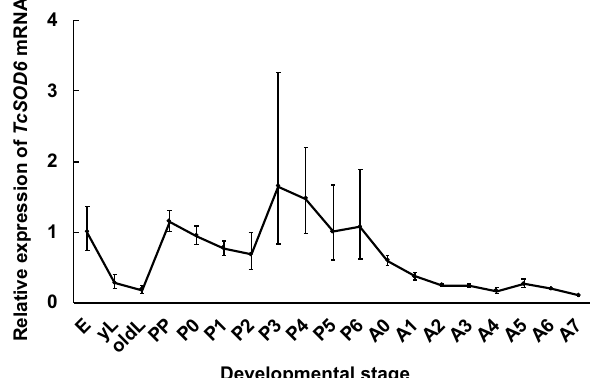
Figure 3. TcSOD6 mRNA expression during development. mRNA expression of TcSOD6 during development. E; embryo (n = 30), yL; young larva (n = 3), oldL; old larva (n = 3), PP; pharate pupa (n = 3), P0–P6; day 0–6 of the pupal stage (n = 3, respectively), A0–A7; day 0–7 of the adult stage (n = 3, respectively). For these samples, mRNA expression levels in the whole body are presented as RQ values, which represent the relative expression levels calculated using embryo samples as 1. Error bars indicate standard deviations from three individual experiments. TcRpS6 was used as an endogenous control.